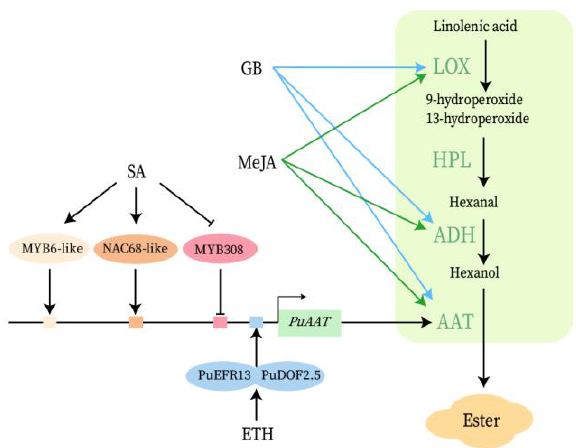
Figure 4. Phytohormones regulate ester biosynthesis in the ‘Nanguo’ pear. GB, Glycine betaine; MeJA, Methyl jasmonate; SA, Salicylic Acid; ETH, ethylene. LOX: lipoxygenase; HPL: hydroperoxide lyase; ADH: alcohol dehydrogenase; AAT: alcohol acyl-CoA transferase.